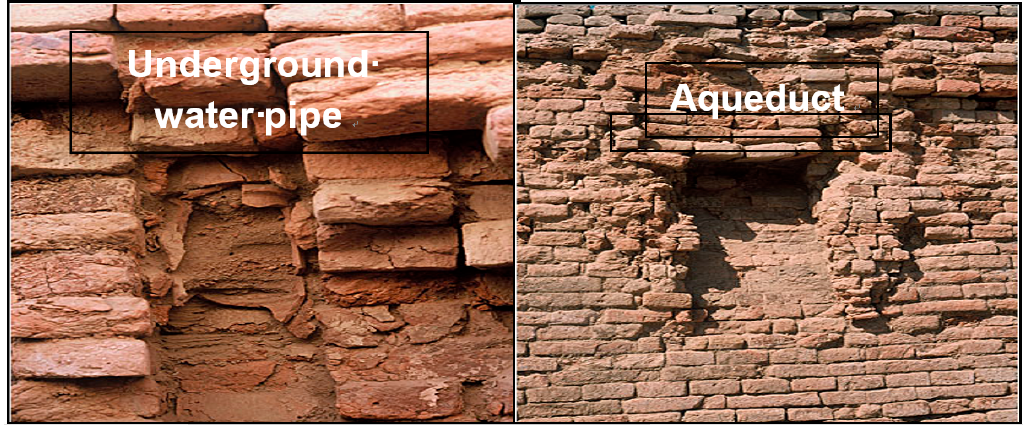
Figure 3. Underground pipe/aqueduct at Mohenjo Daro, Pakistan (modified from [32]).